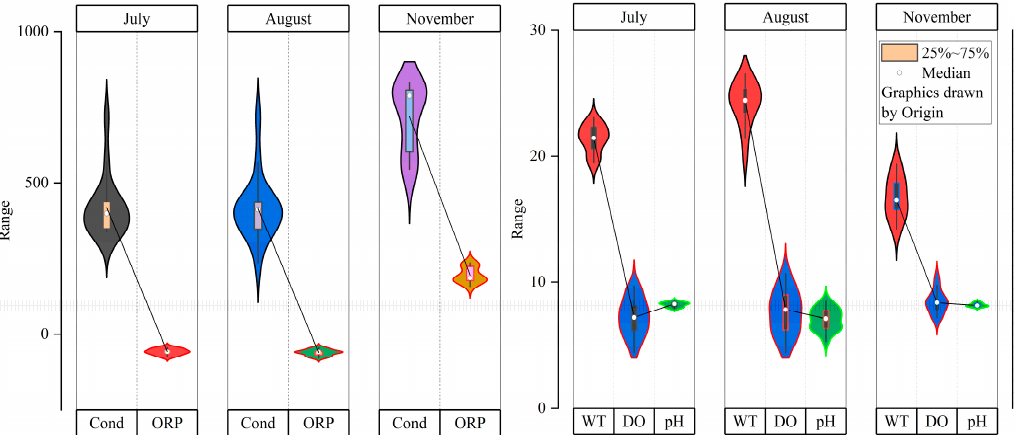
Figure 2. Spatiotemporal values of water quality parameters at 17 locations within the Maotiao River Basin (Gizhou province, SW China) in 2020. Cond: electric conductivity; ORP: oxidation–reduction potential; WT: water temperature; DO: dissolved oxygen; pH: acidity/alkalinity.